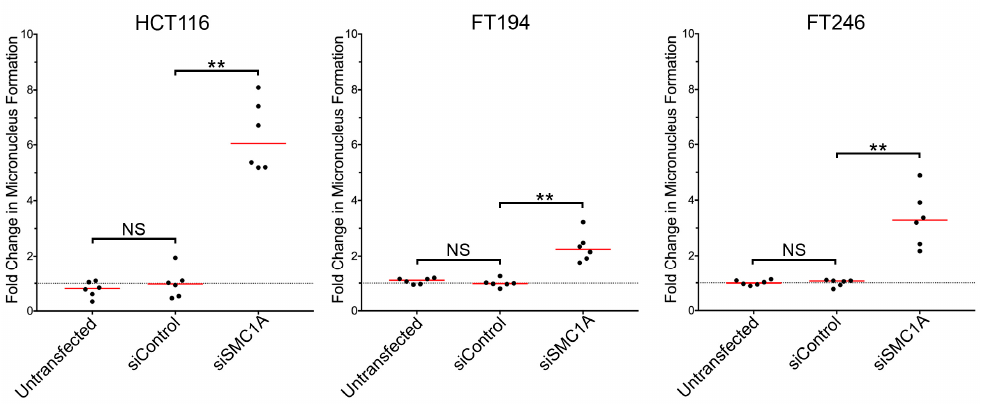
Figure 4. Increases in micronucleus formation accompany reduced SMC1A expression. Mann-Whitney tests reveal statistically significant increases in the fold change in micronucleus formation following SMC1A silencing relative to siControl in HCT116 (left), FT194 (middle) and FT246 (right) cells (NS, not significant; ** p -value < 0.01; N = 3). Data are presented relative to the siControl with red lines identifying the median and the dashed horizontal line identifying the mean of the siControl (1.00).